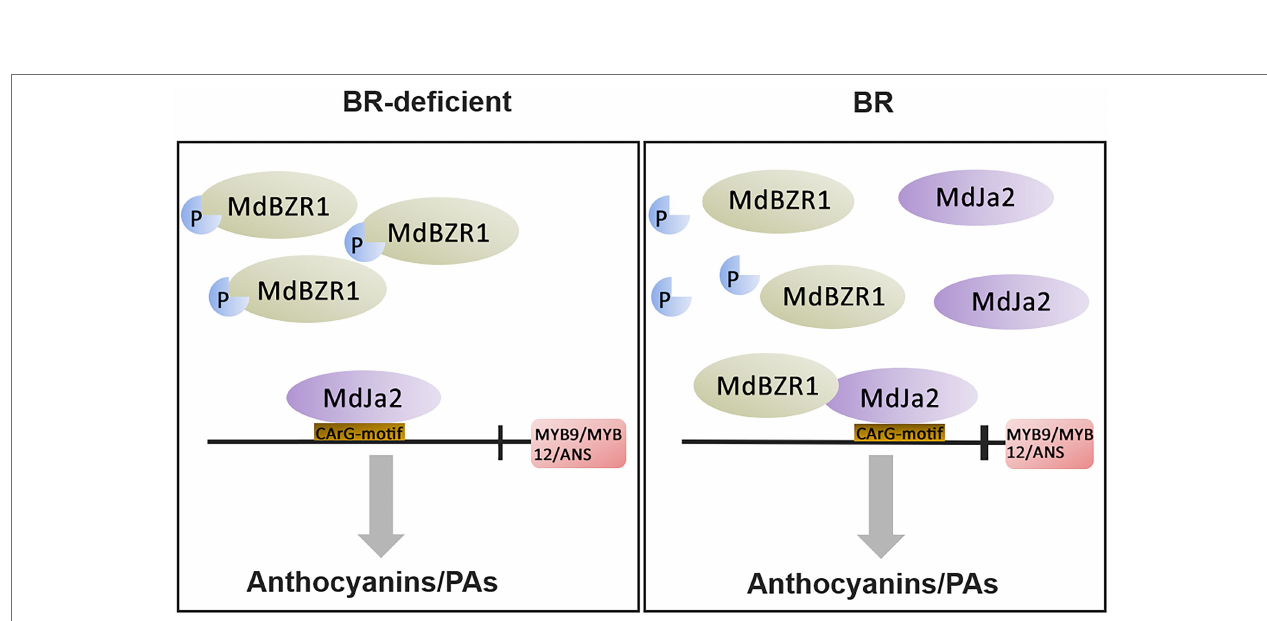
FIGURE 8 | Proposed model for BR-regulated anthocyanin and proanthocyanidin biosynthesis mediated by the interaction between MdJa2 and MdBZR1. When plants are treated with BR, MdJa2 accumulates and most MdBZR1 proteins exist in a dephosphorylated active state, which considerably increases the possibility that MdBZR1 and MdJa2 will form a complex. This complex inhibits anthocyanin and PA synthesis by modulating the transcriptions of downstream target genes. P indicates phosphorylation modification, CArG-motif indicates binding element, vertical line indicates inhibition, and bold vertical line indicates enhanced